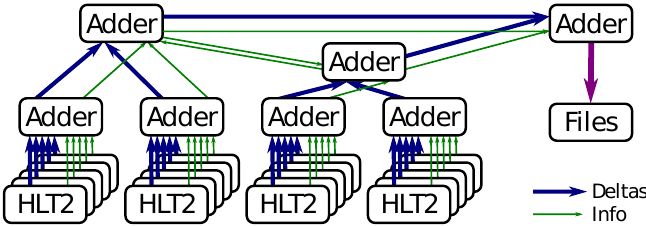
Figure 3. HLT2 monitoring system scheme. The EFF is split in sub-farms pushing deltas and info messages to the sub-farm adders. Sub-farm adders merge and push the information to the top-level adders, responsible to merge and publish the full histograms and